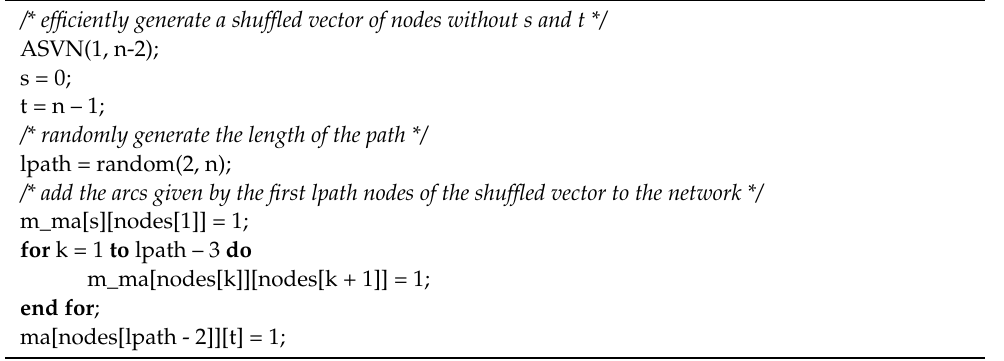
Algorithm 5. Algorithm Random s-t Directed Elementary Path v2 (ARDEP2)